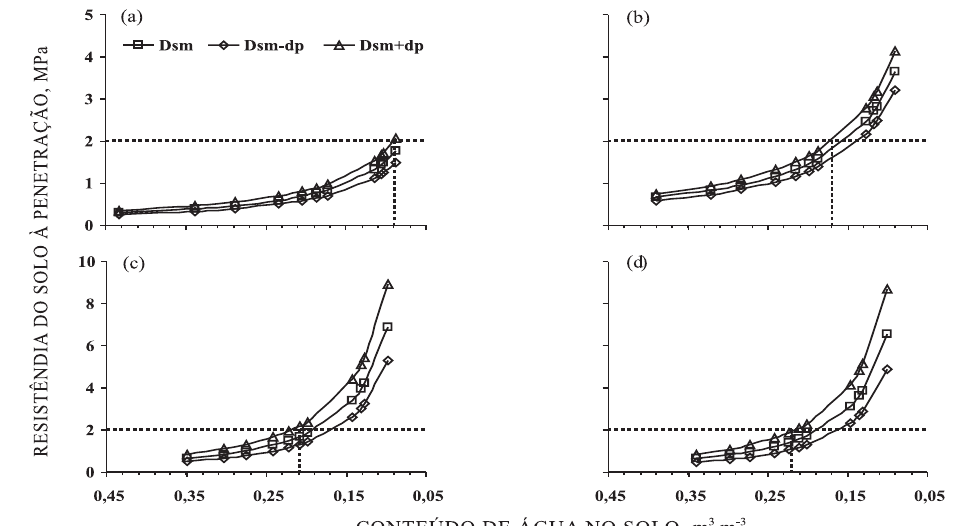
Figura 2. Variação da resistência do solo à penetração (RP), considerando o conteúdo de água do solo ( θθθθθ ) para diferentes valores de densidade do solo (Ds) para os tratamentos mata nativa (a), pastagem (b), citros (c) e culturas anuais (d). Dsm + dp = densidade média do solo + 1 desvio-padrão; Dsm = densidade média do solo para cada tratamento, Dsm-dp = densidade média do solo-1 desvio-padrão. As linhas horizontais correspondem à RP crítica adotada (RP = 2 MPa) e as linhas verticais correspondem ao conteúdo de água em que a RP torna-se maior que 2